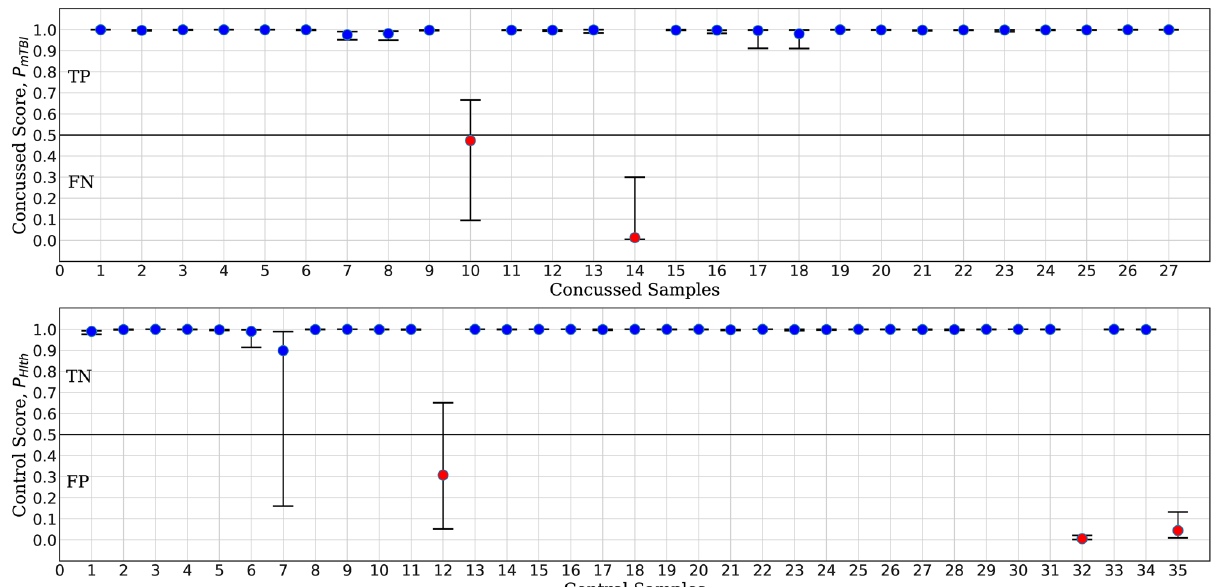
Figure 5. Statistics of the output layer scores for each participant in the concussed (upper panel) and control (lower panel) groups. The scores distributions are obtained from the Monte Carlo cross validation tests in Stage 3. The statistics shown include the median (circle markers) and the 25th and 75th quartiles (whiskers) of the concussion scores P mTBI for the 27 concussed participants (upper panel). For the 35 control participants, the statistics involve the median and respective quartiles of the complementary scores P Hlth ≡ ( 1 − P mTBI ) . Correctly classified participants (blue markers) have a median concussion score exceeding the threshold of 0.5 (concussed group) and respectively below 0.5 (control group). Correct classifications include true positives (TP) in the concussed group and true negatives (TN) in the control group. Red markers correspond to individuals who were misclassified based on their median scores; these involve two false negatives (FN) in the concussed group and three false positives (FP) in the control group. ( Plotted with Matplotlib v3.2.1 75